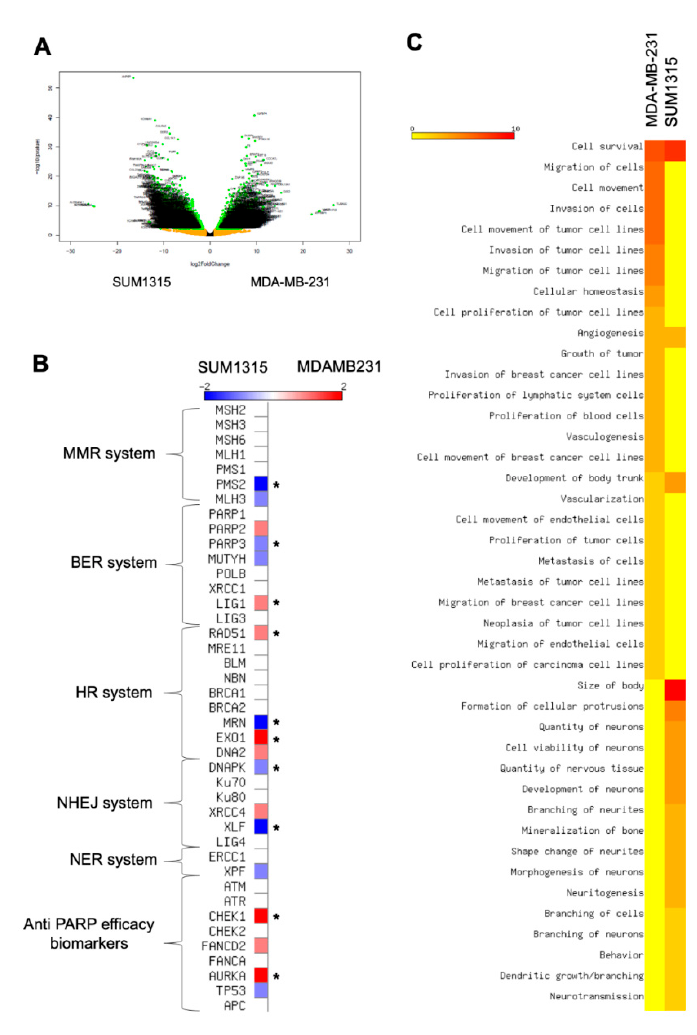
Figure 7. Transcriptomic analysis of MDA-MB-231 and SUM1315 cell lines: determination of cell di ff erence in sensitivity by a Di ff erential Expressed Gene analysis ( A , B ) and a functional phenotype analysis ( C ). ( A ) Volcanoplot of the Di ff erential Expressed Genes between MDA-MB-231 and SUM1315 cell lines. The y-axis corresponds to the mean expression value of log 10 ( p -value), and the x-axis displays the log 2 fold change value. Each point represents a gene. The green dots represent the significant up / down expressed genes (adjusted p value < 0.05, log 10 > 1) whereas the orange dots represent the non-significant di ff erentially significant genes. Genes symbol are indicated. ( B ) Expression levels of keys genes involved in DNA reparation mechanisms (mismatch repair system “MMR”, base excision repair system “BER”, homologous recombination system “HR”, non homologous end-joining repair system “NHEJ”, nucleotide excision repair system “NER”). The heatmap shows the expression level of key genes involved in di ff erent DNA reparation pathways. These last are indicated beside the heatmap. Asterisk marks designated genes which are significantly di ff erential expressed genes between the two cell lines: MDA-MB-231 and SUM1315, * p < 0.01. ( C ) Determination of MDA-MB-231 and SUM1315 cell lines functional phenotype by an Ingenuity Pathway (IPA) analysis. The heatmap shows the cellular functions that were inferred to be associated with enriched DGE clusters between MDA-MB-231 and SUM1315 cell